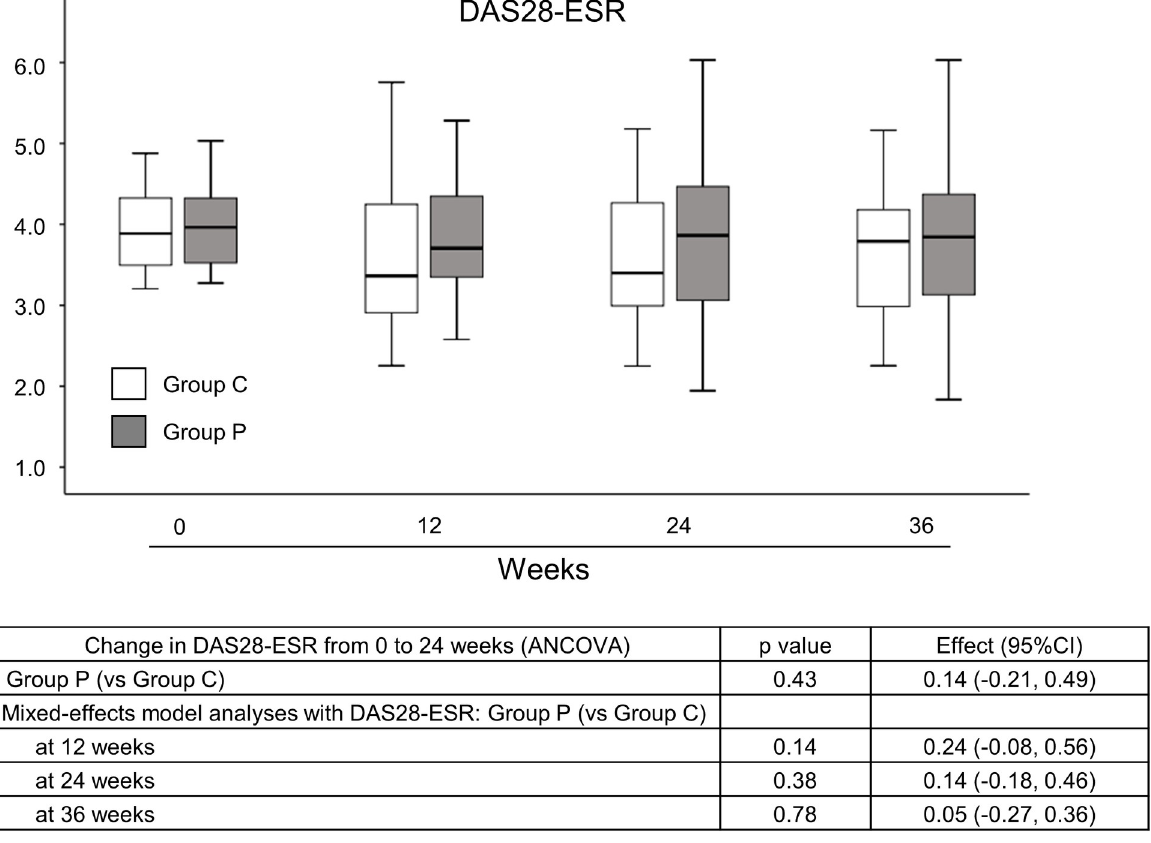
Fig 2. Changes in DAS28-ESR over the course of the study in the FAS. Data are presented as box-and-whisker plots. White box, Group C; gray box, Group P. ANCOVA; analysis of covariance, C, control; CI, confidence interval; DAS, disease activity score; ESR, erythrocyte sedimentation rate; P,